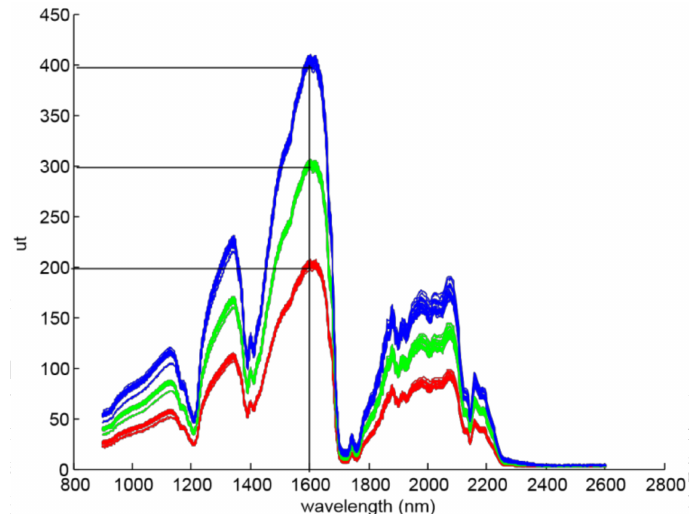
Figure 3. Olive oil sample spectra for the three groups: S1 in red, S2 in green, and S3 in